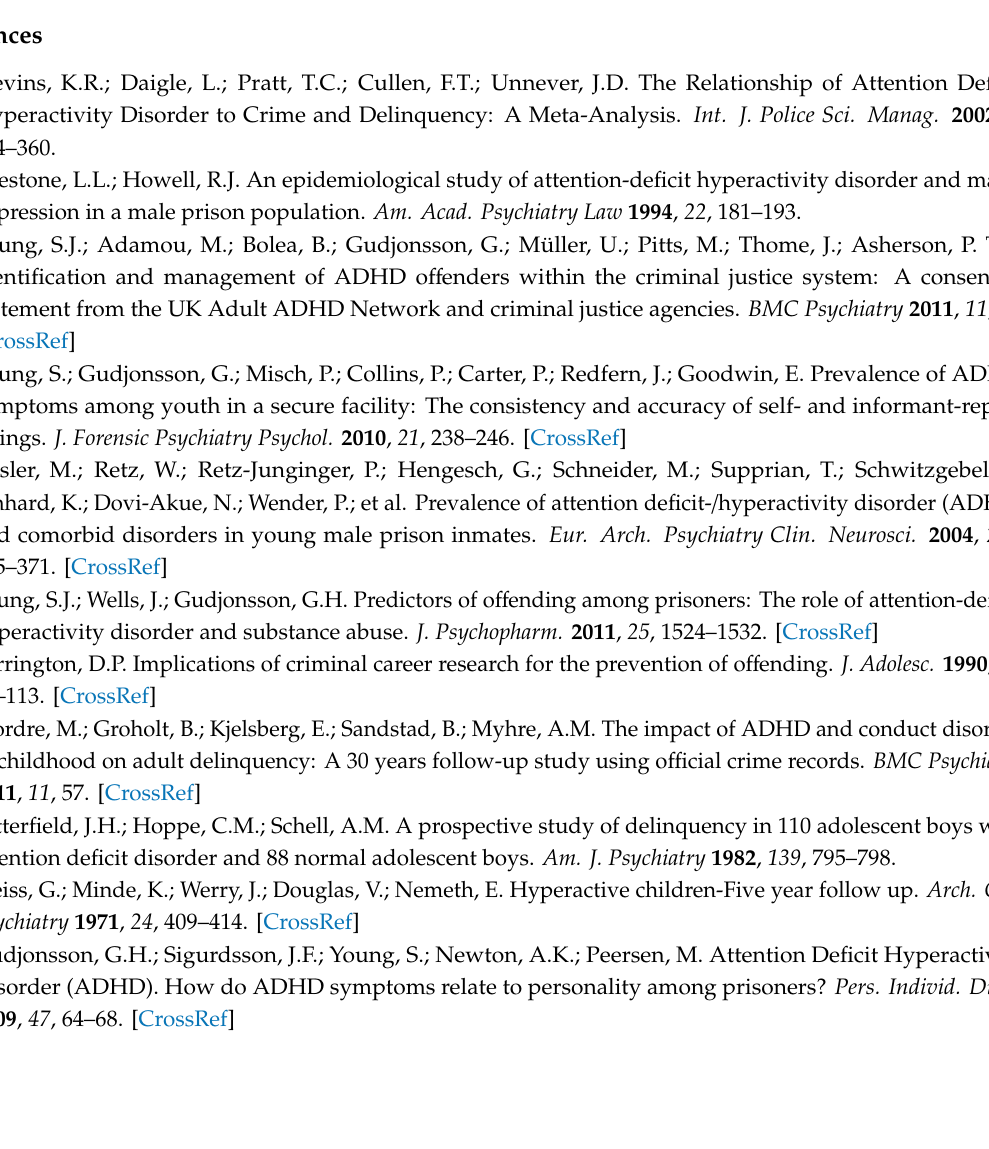
Table S1: Results of the two main regression analyses following potential outlier exclusion (compare Table 4 main text). Table S2: Bivariate correlations between variables. Table S3: Regression coe ffi cients for retained predictor variables on total criminal thinking for high ADHD scorers ( N =